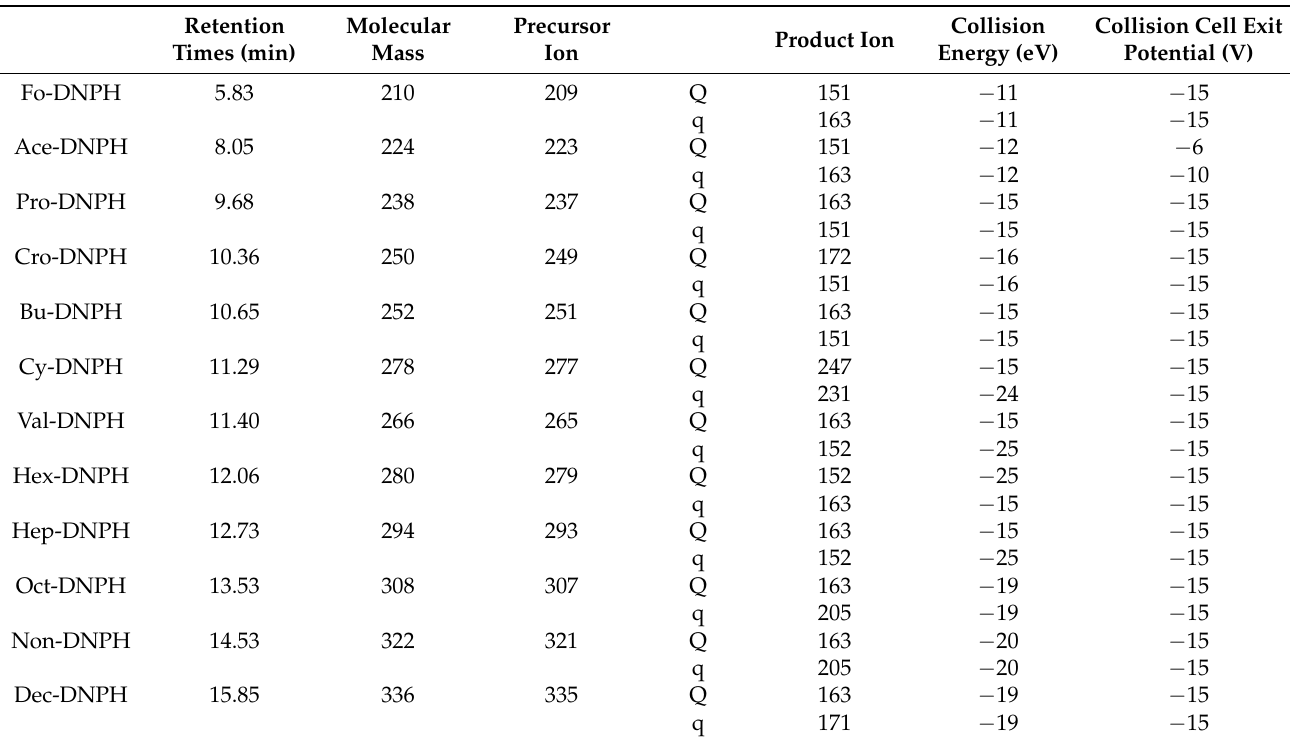
Table 2. Optimized spectrometric conditions for each studied analyte. The letter “Q” indicates the ion that was chosen as quantifier, the letter “q” indicates the ion that was chosen as